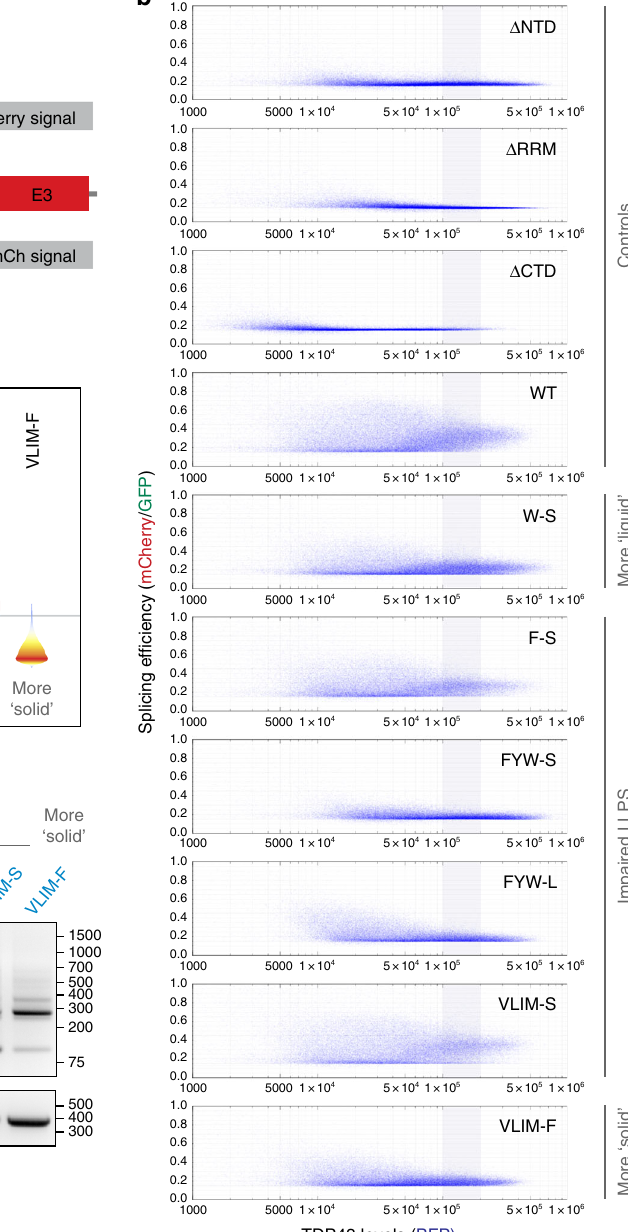
ef fi ciency of exogenous full-length TDP43 (WT) to TDP43 var- iants lacking the RNA-binding domains ( Δ RRM), the N-terminal domain ( Δ NTD) or the C-terminal domain ( Δ CTD). Re- expression of TDP43 WT in TDP43 − / − cells rescued the exon- skipping defect, whilst TDP43 Δ RRM was non-functional